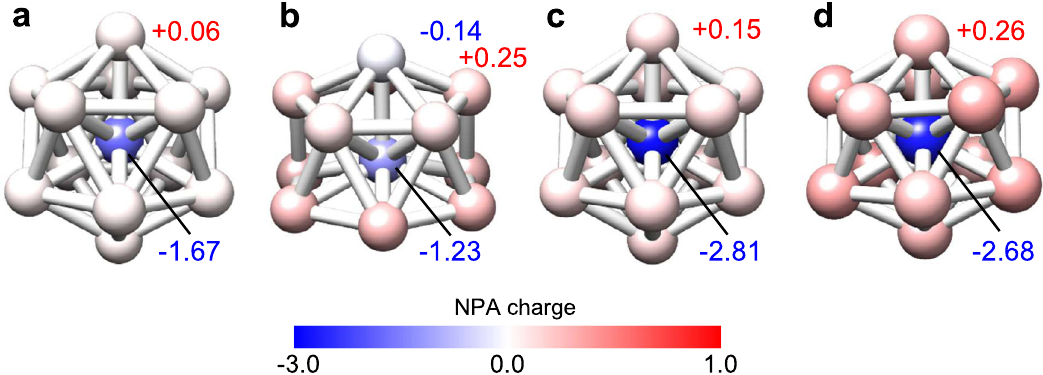
Fig. 5 Calculated NPA charge distributions for Al 13 and B@Al 12 . a – d Natural population analysis (NPA) distributions for a Al 13 − , b Al 13 + , c B@Al 12 − , and d B@Al 12 + for the optimized structures using PBE0 with 6-311 + G(d) for Al 13 − and B@Al 12 − or with 6-311G(d) for Al 13 + and B@Al 12 + . Along with the representative values, the charge amount is expressed by the color gradation: positive in red and negative in blue. The icosahedral I h symmetries for Al 13 − and B@Al 12 − are lowered to C 1 for Al 13 + and C i for B@Al 12 + owing to electron de fi ciency in the 2P shell. In general, a central Al/B atom is negatively charged, while the surface Al atoms are positively charged, with the exception of a top Al atom in the distorted Al 13 + in ( b